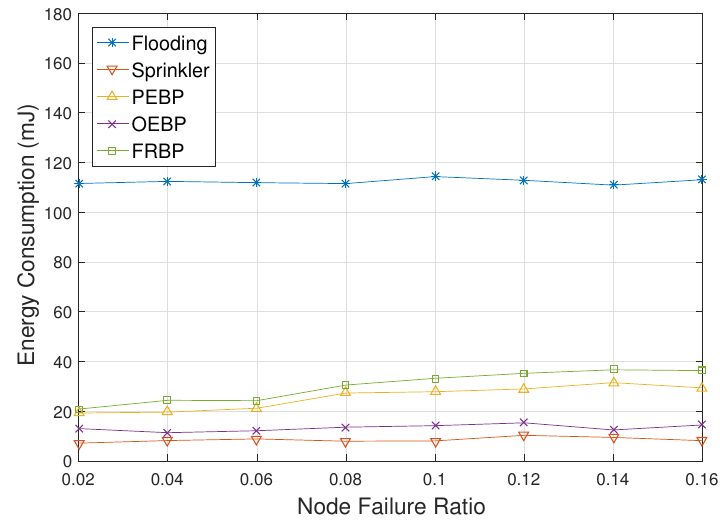
Figure 9. Average energy consumption impacted by the node failure